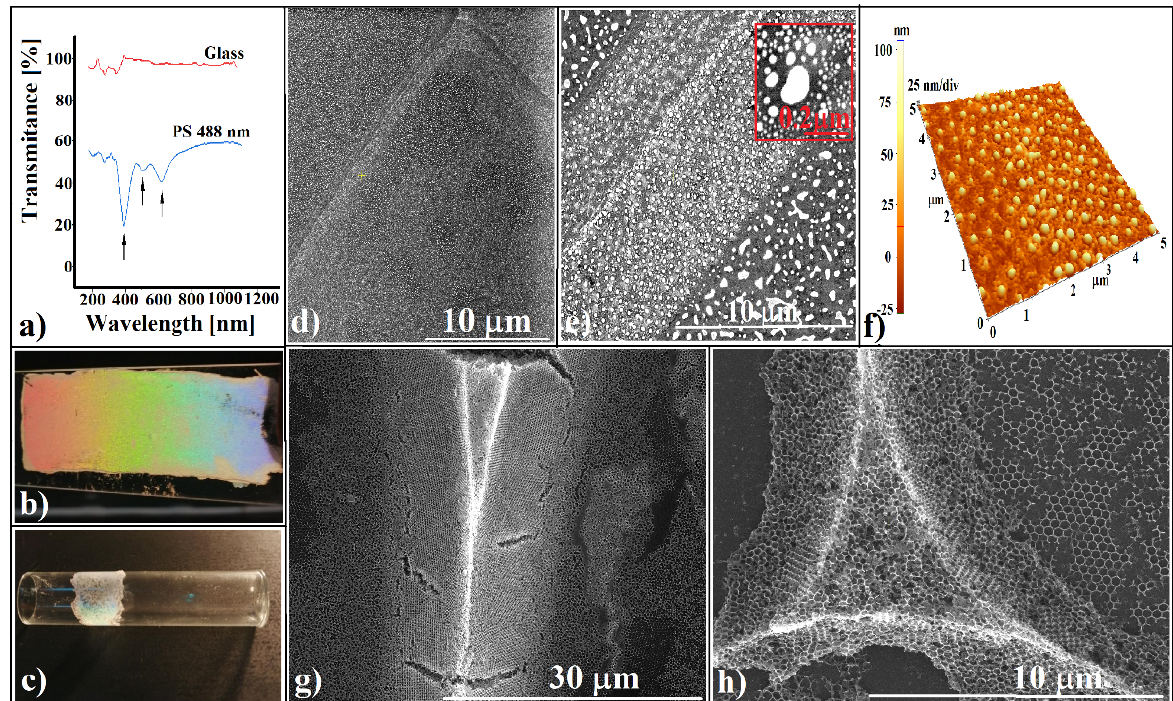
Figure 5. ( a ) UV-Vis spectra of white light transmission trough a patterned, shaped colloidal crystal; ( b ) image of super-prism effect of a patterned and shaped colloidal crystal formed onto a flat substrate; ( c ) image of super-prism effect of a patterned and shaped colloidal crystal formed onto a curved substrate; ( d , e ) SEM images of the Au nanometric array resulted by using a triangular prism colloidal crystal as lithographic mask; ( f ) AFM image of the Au nanometric array; ( g , h ) SEM images of a triangular prism and a knot, inverted